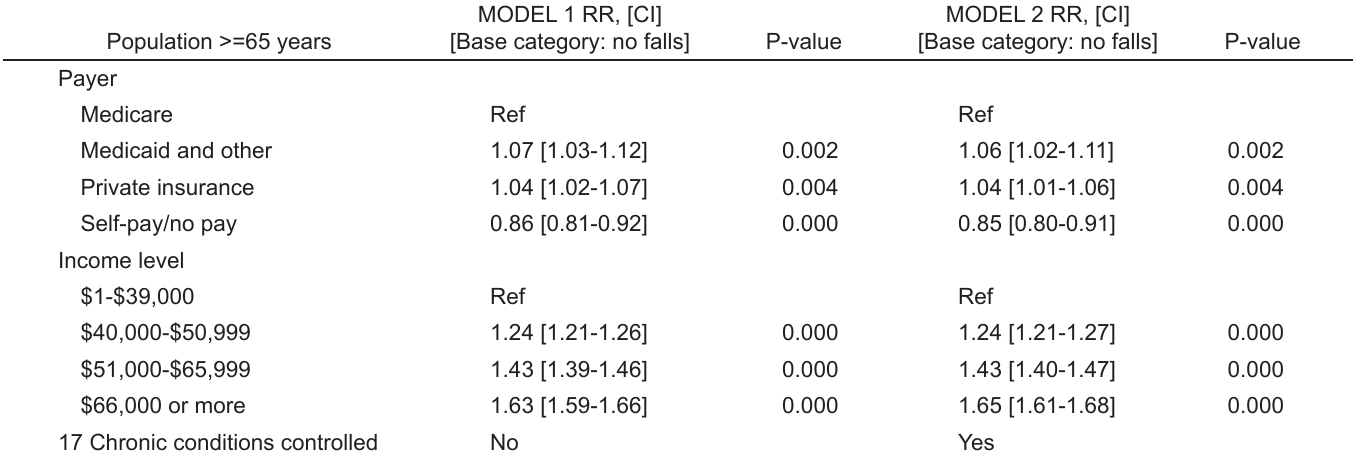
*Missing values were about 3% of the